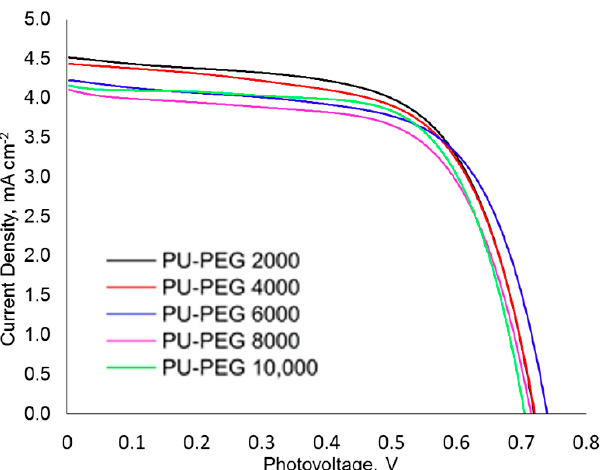
Figure 9. Current density-photovoltage curves of DSSCs based on PU matrices with different PEG molecular weights. Table 2. Photovoltaic performance of DSSCs based on PU matrices with different PEG molecular weights.